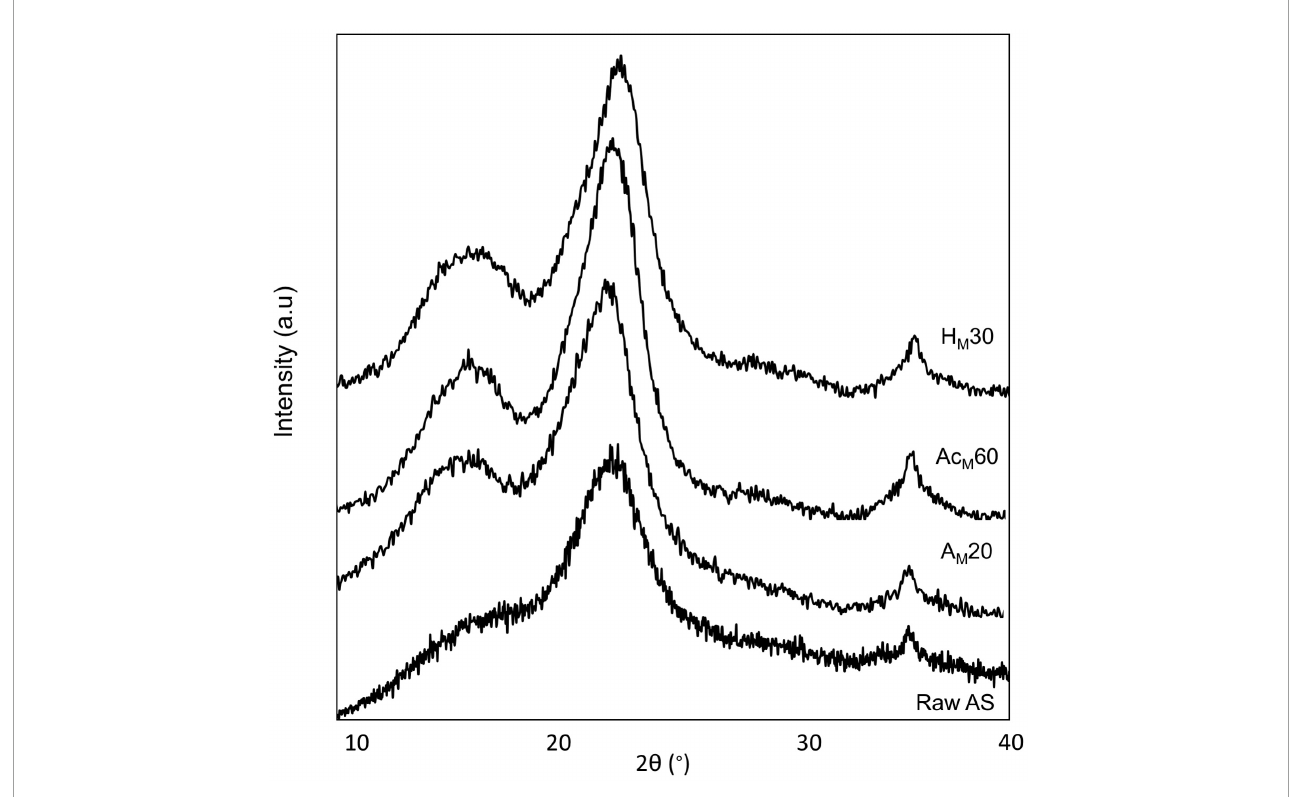
FIGURE6 XRD patterns of raw AS, A M 20, AC M 60, and H M 30